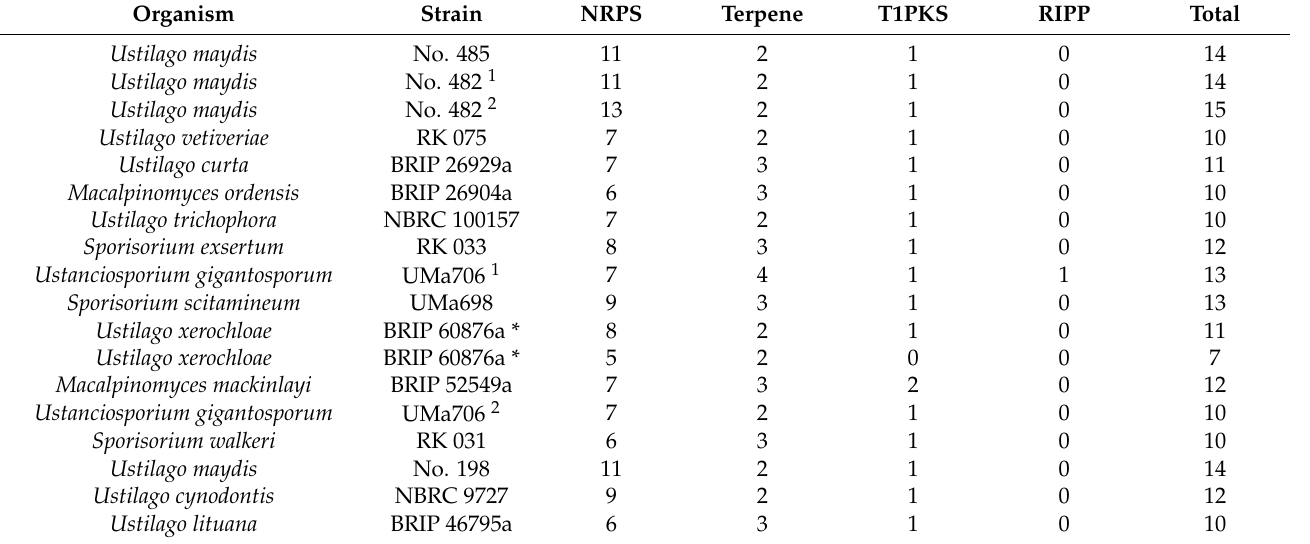
Table 3. Investigation of secondary metabolite synthesis via antiSMASH analysis [58]. 1,2 Two isolates were sequenced, contains * diploid/+ additional